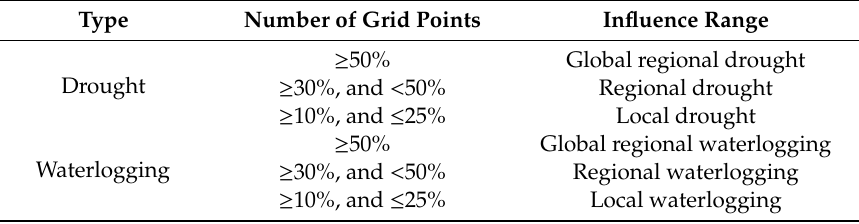
Table 3. Classification of the range of influence of drought and waterlogging for maize.